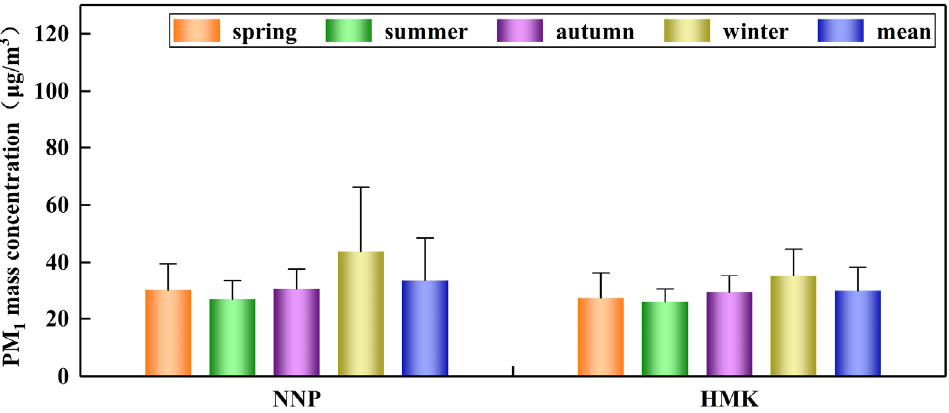
Figure 3. Seasonal distribution characteristics of the PM 1 mass concentrations in Panzhihua (NNP, HMK).